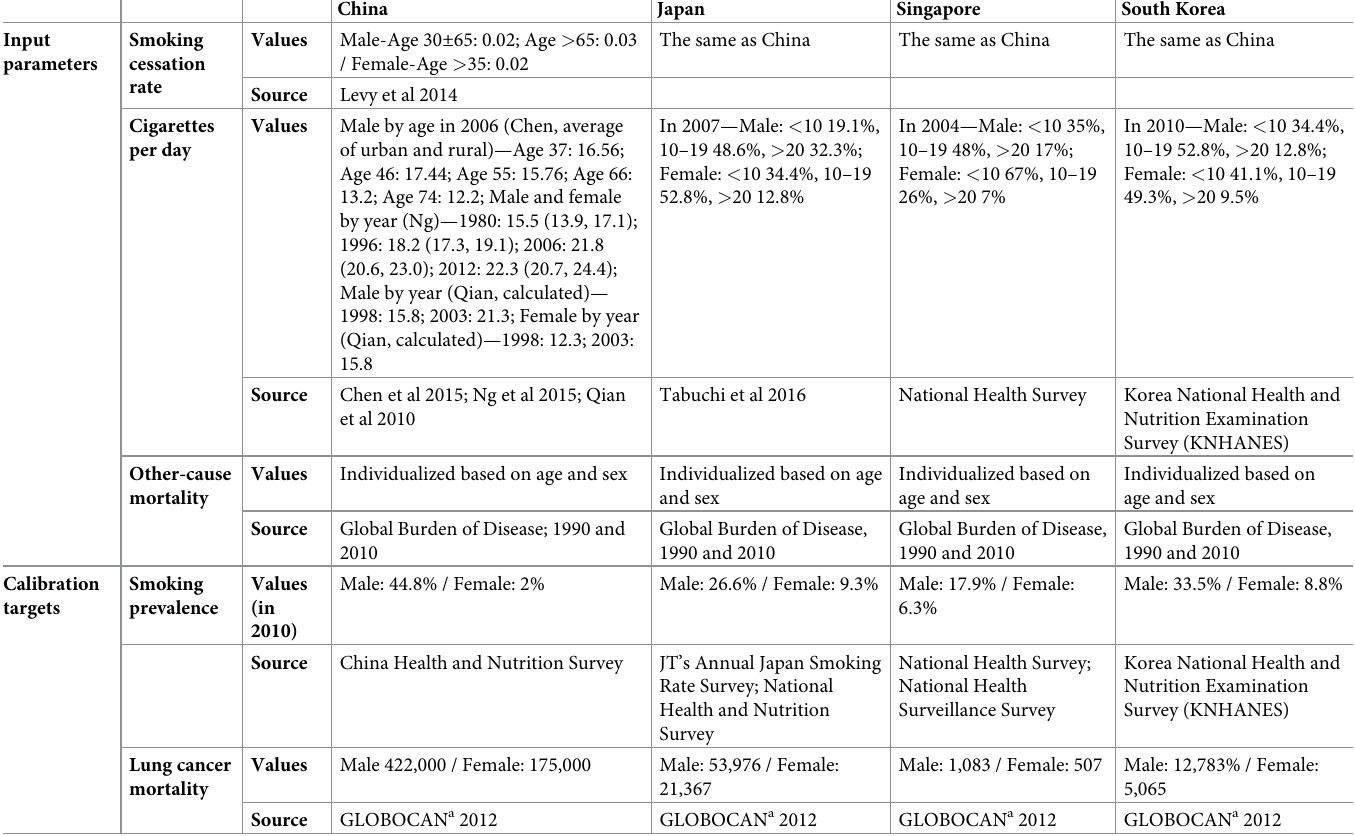
Table 1. Lung Cancer Policy Model–Asia input parameters and calibration